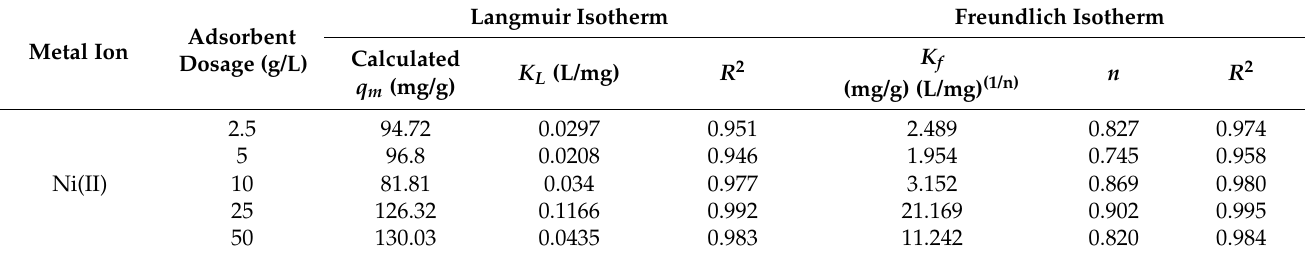
Table 4. Isotherm model parameters for adsorption of Ni(II) using SS-FA.